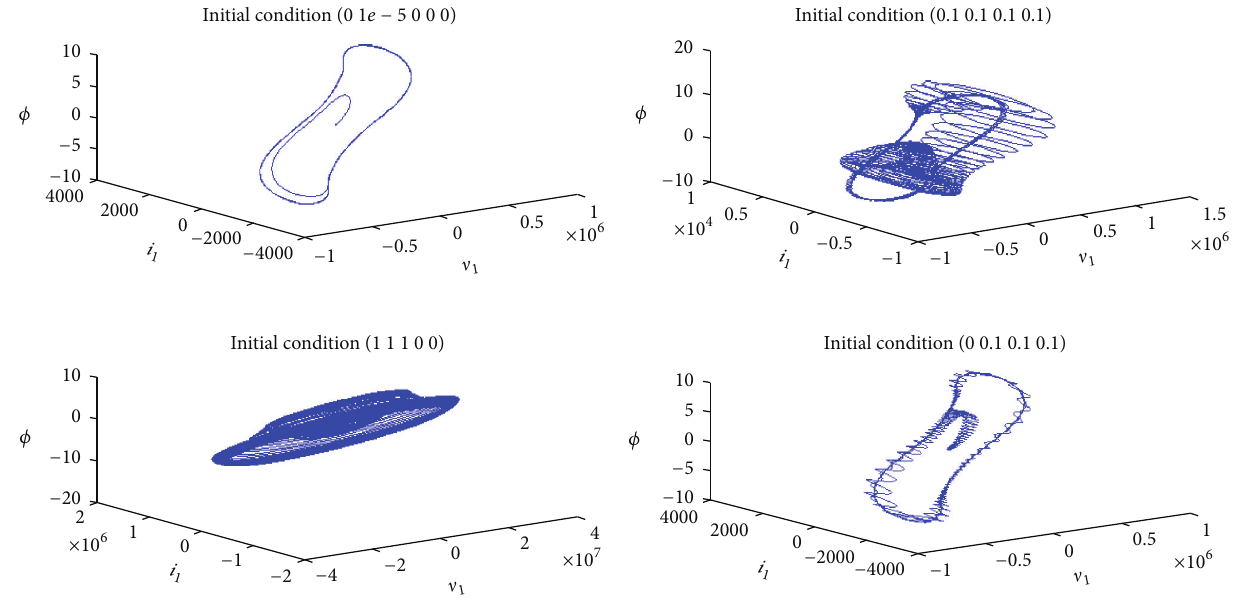
Figure 6: 3D Chaotic attractor in different initial conditions.